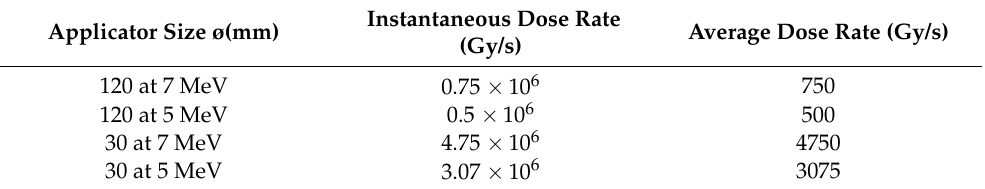
Table 3. Dose rate measurements with the film (uncertainty of 5%), obtained with different applicators for a pulse duration of 4 µ s at energies of 5 MeV and 7 MeV.